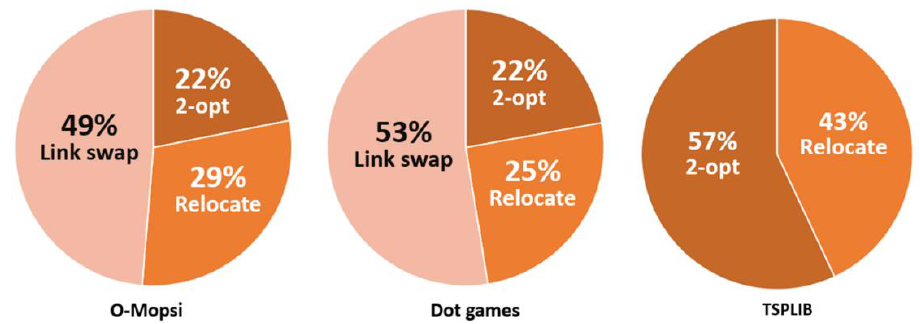
Figure 21. Share of the improvements by all three operators both with the open-loop (O–Mopsi and Dot games) and closed-loop (TSPLIB) problem instances. With TSBPLIB, we use 10 8 iterations and 25 repeats.